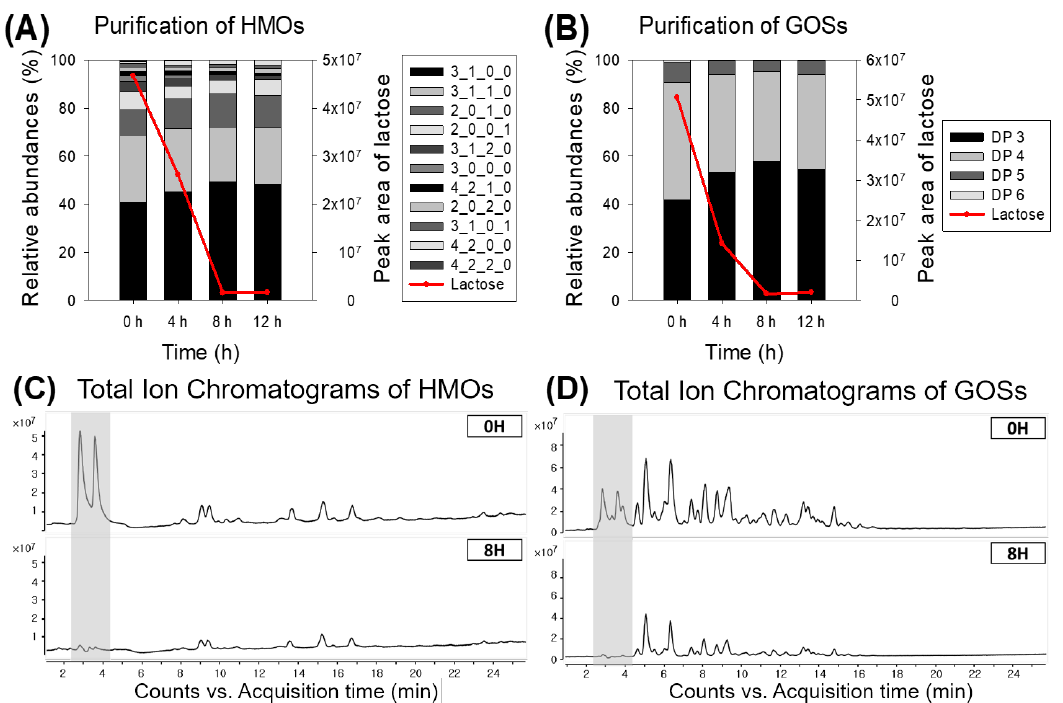
Figure 3. The change of the peak area of lactose and the relative abundances of oligosaccharides during the biopurification of ( A ) human milk oligosaccharides (HMOs) and ( B ) galactooligosaccharides (GOSs) by immobilized K . lactis . Moreover, the representative total ion chromatograms of ( C ) HMOs and ( D ) GOSs are shown. Ions in the shaded area were confirmed to be lactose. Due to the characteristics of the porous graphitized carbon cartridge (PGC) column, oligosaccharides with aldehyde form were separated into two peaks which indicated the α – and β – forms.